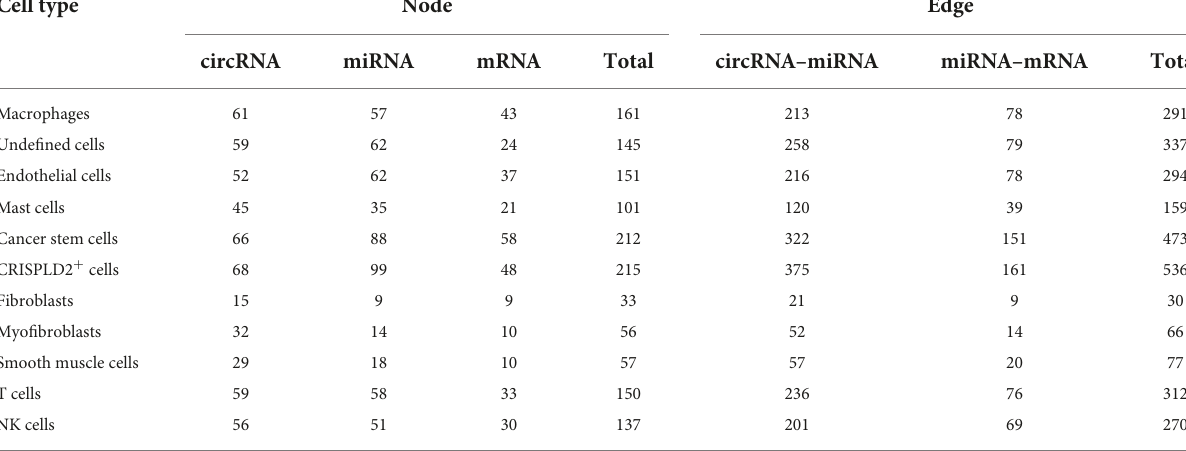
TABLE 4 The numbers of nodes and relation pairs (edges) in the circRNA–miRNA–mRNA network of each cell type. Cell